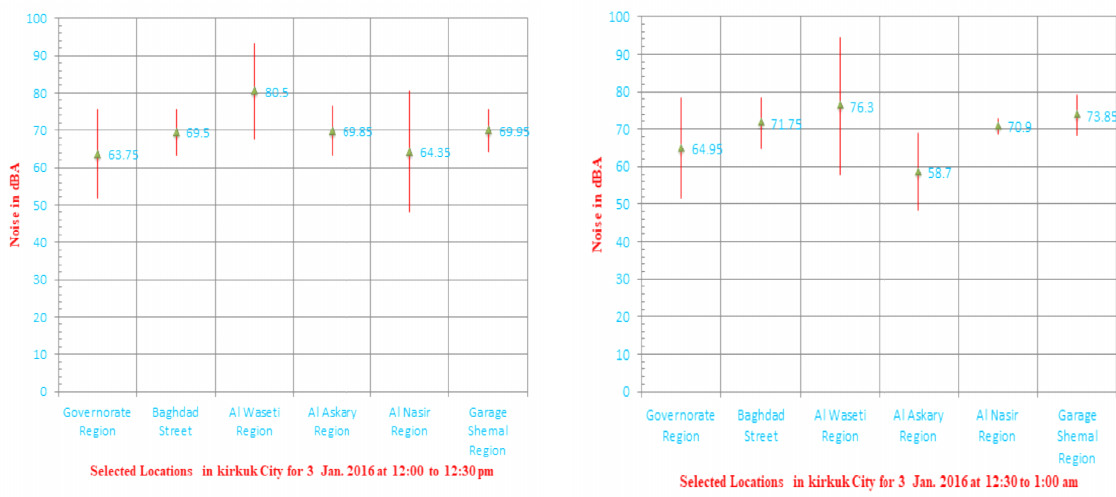
Fig. 8. Max, Min and Average Hourly Noise Max, Min and Average Hourly Noise Distribution for the traffic flow 3 Jan. 2015 Kirkuk City. Distribution for the traffic flow 3 Jan. 2015 Kirkuk City.